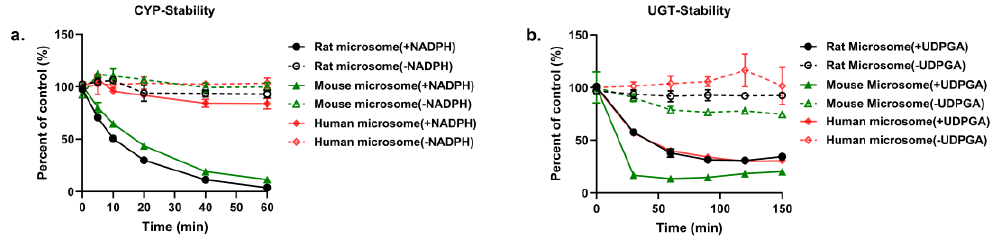
Figure 6. Depletion profiles of PND in rat, mouse and human LMs by CYPs ( a ) and UGTs ( b ) ( n = 3). Table 3. Enzyme kinetic parameters in rat, mouse and human LMs.